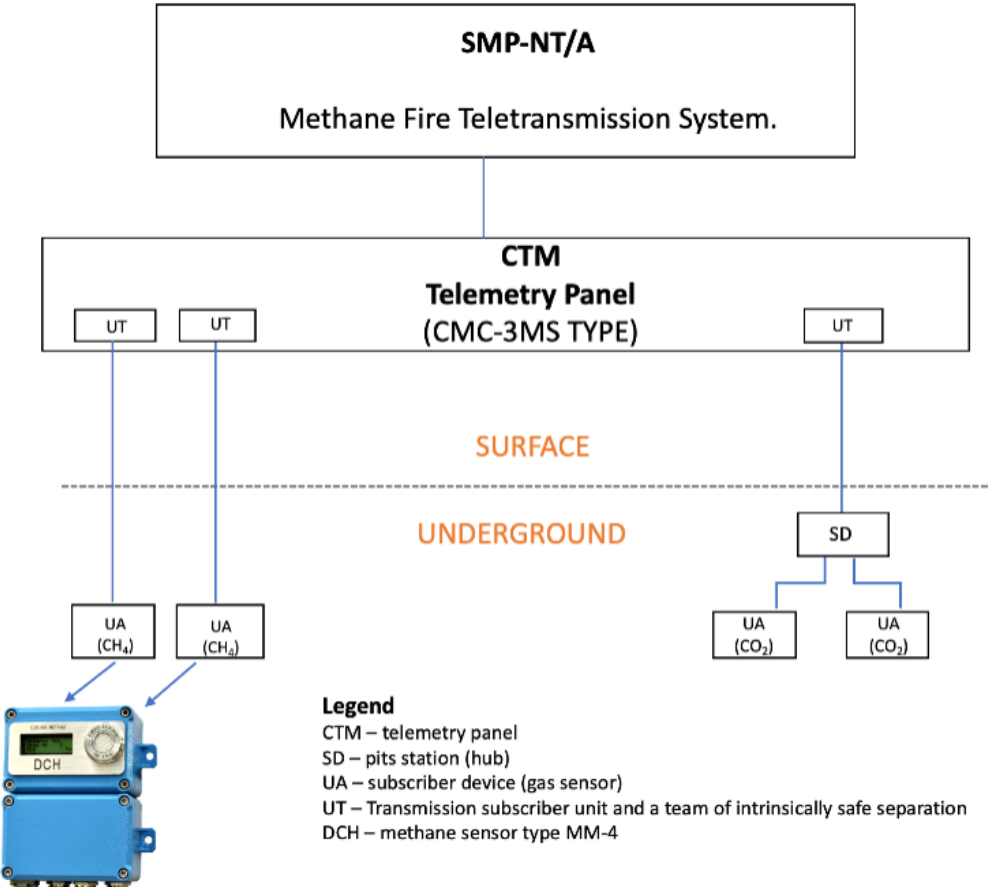
Figure 3. Block diagram of a system for monitoring environmental parameters with a star-shaped structure of the teletransmission network, frequently employed in Polish coal mines, including the commonly used methane sensor type MM-4 (production by EMAG-Serwis sp. z o.o.;